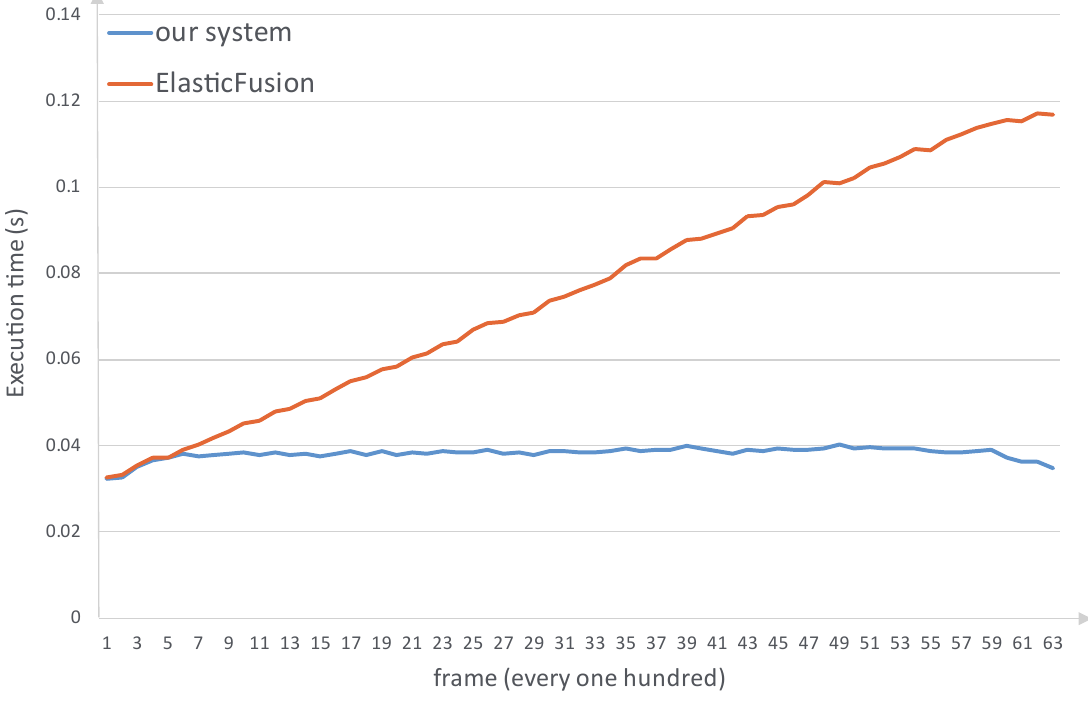
Figure 12. The execution time of ElasticFusion and our system when processing the stairs sequence. We calculate the average execution time per 100 frames. The frame rate of ElasticFusion slows down as more frames are fused. In contrast, our system holds